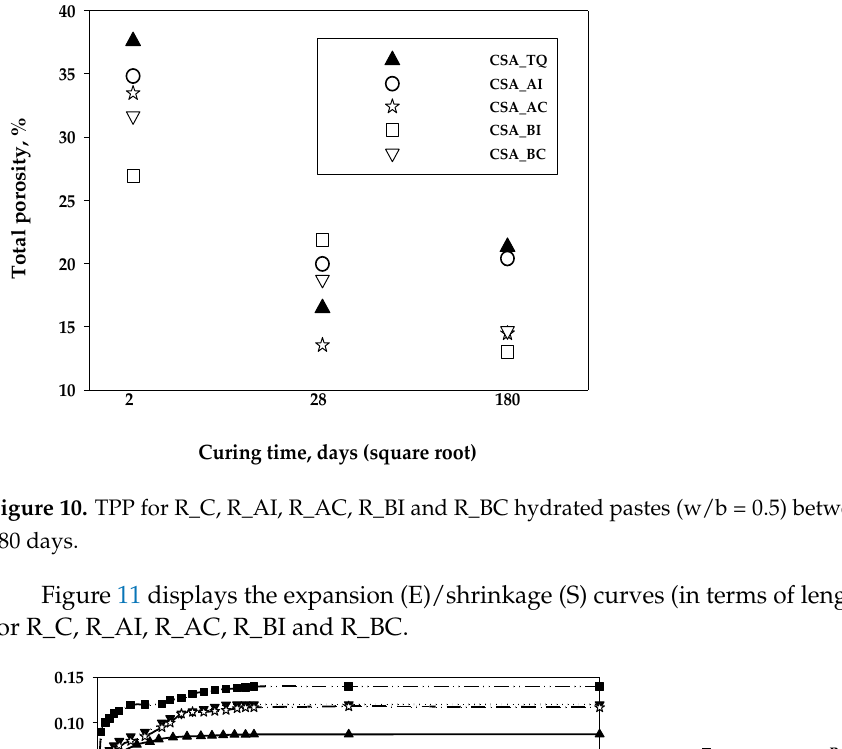
Figure 9. Cumulative Hg volume as a function of pore radius for C_R ( a ), C_AI ( b ), C_AC ( c ), C_BI ( d ) and C_BC ( e ) hydrated pastes (w/b = 0.5) at 2, 28 and 180 days. Finally, Figure 10 shows the total porosity percentage (TPP) for the five systems as a function of curing time.